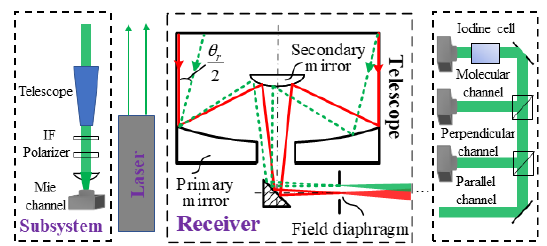
Fig.1 The system layout of dual field-of-view HSRL system.